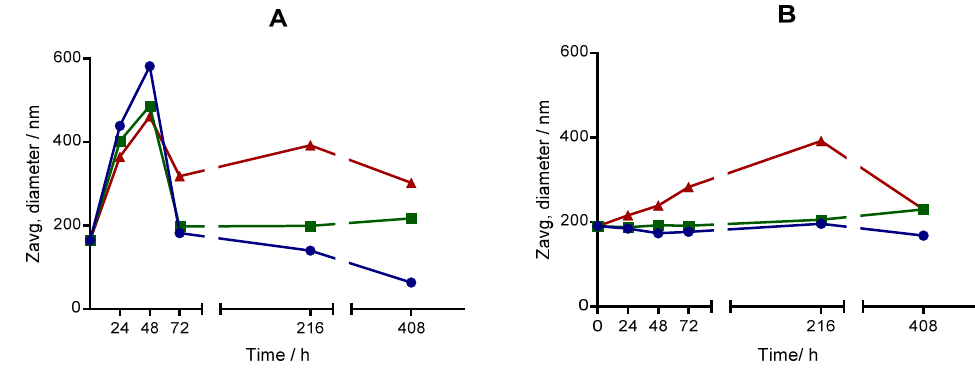
Figure 5. Long-term stability of nanoemulsions at 4 ◦ C (blue dots), room temperature (green squares) and 37 ◦ C (red triangles). Solid lines are guidelines. ( A ) High energy nanoemulsion, and ( B ) Low energy nanoemulsion